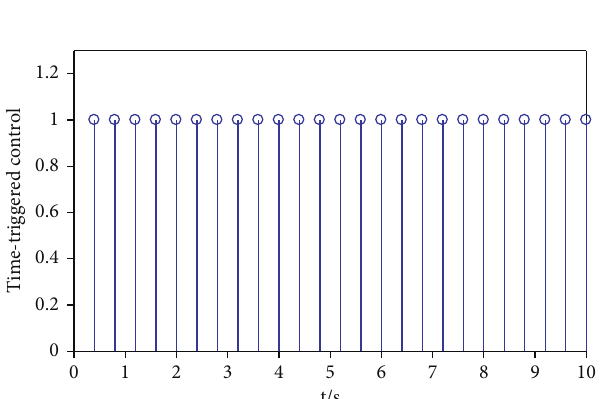
Figure 5: Regulated output.